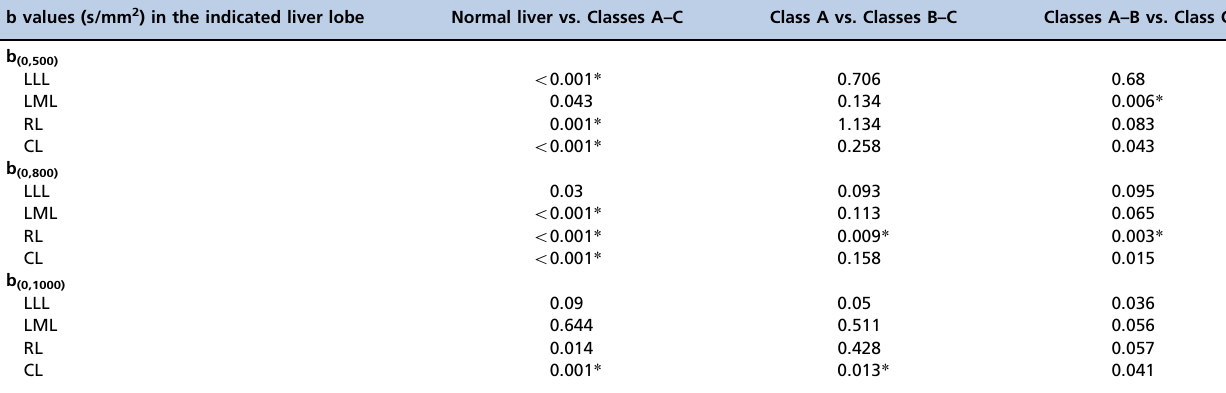
Table 4 - P -values for the statistical comparisons of liver lobe-based apparent diffusion coefficients ( (cid:1) 10 -3 mm 2 /s) between groups of Child-Pugh classes of cirrhosis. b values (s/mm 2 ) in the indicated liver lobe Normal liver vs. Classes A–C Class A vs. Classes B–C Classes A–B vs. Class